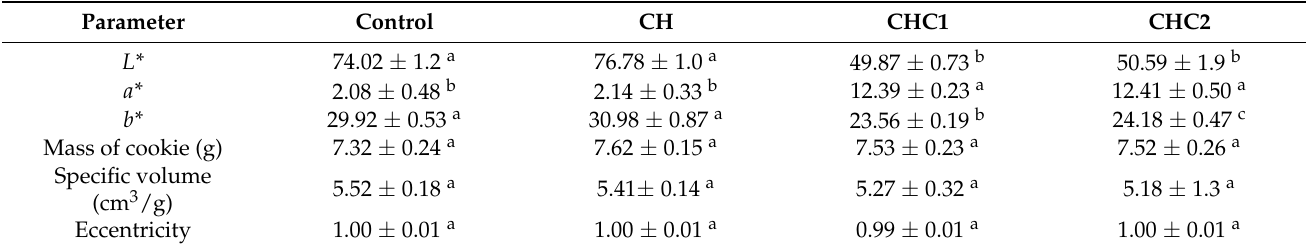
Table 4. Color parameters and physical properties of gluten-free cookies.